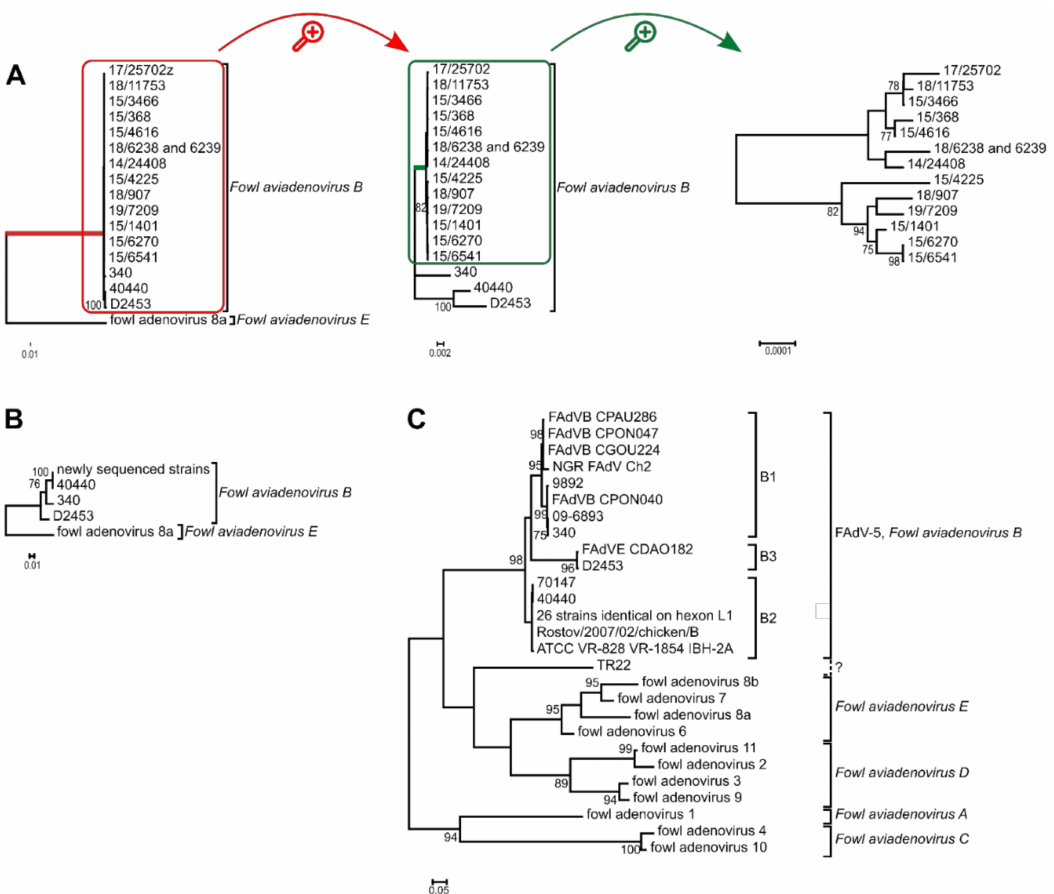
Figure 2. Phylogenetic analysis of Fowl aviadenovirus B strains based on the ( A ) complete genome sequence, ( B ) the hexon amino acid sequence and the ( C ) hexon loop-1 (L1) nucleotide sequence. Trees ( A , B ) were rooted on fowl adenovirus 8a, whereas tree ( C ) was midpoint rooted. ( A ) Branch lengths were short within the species Fowl aviadenovirus B ; thus, the red highlighted branch of the species is shown separately. From this tree, the green highlighted branch of the newly sequenced strains was separated again to reveal branch lengths among these strains too. ( C ) The 26 identical strains: 160, 177, 2255, 5626, 8844, 45871, 08-21472, 08-8669, 09-7470-2, 09-7473-2, 14/24408, 15/1401, 15/3466, 15/368, 15/4616, 15/6270, 15/6541, 17/25702, 18/11753, 15/4225, 18/6238, 18/6239, 18/907, 19/7209, GB 1643, K318/09. See Table 2 for further